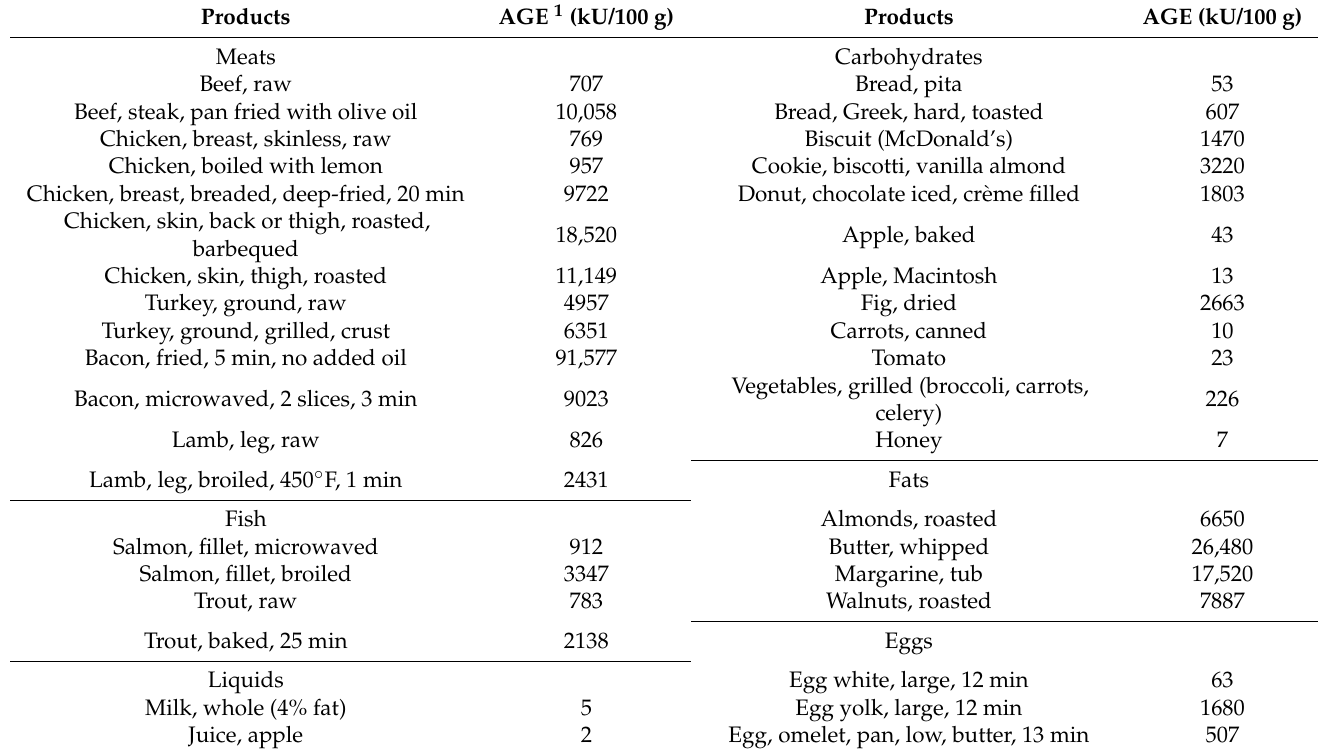
Table 2. The dietary AGE content in